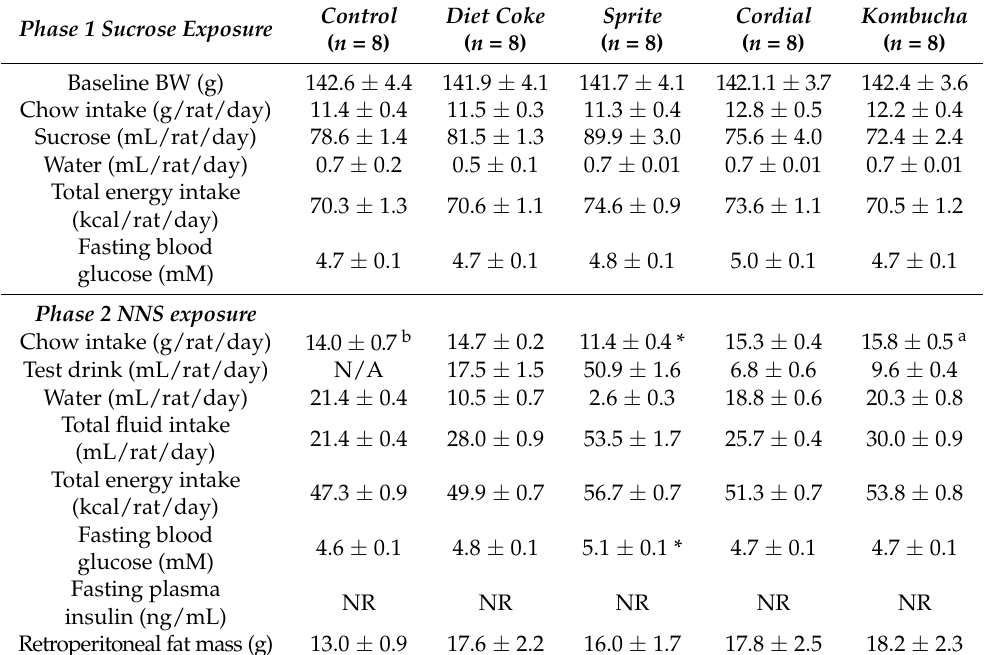
Table 2. Female group means ± SEM for sucrose exposure in Phase 1 and NNS exposure in Phase 2. Phase 1 Sucrose Exposure